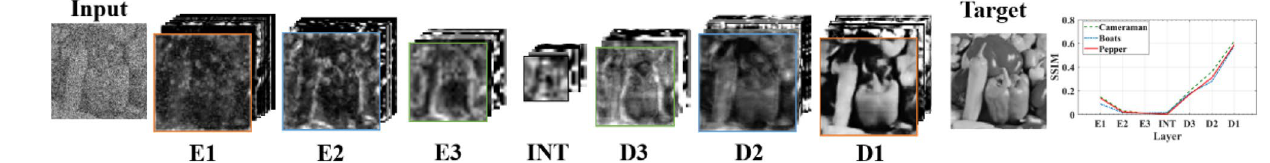
Figure 12. End-to-end Visualization of activation feature maps at different layers in the network. The SSIM plot for different standard test set targets is given to quantify SSIM at different layers. The SSIM increases when the decoding layers start